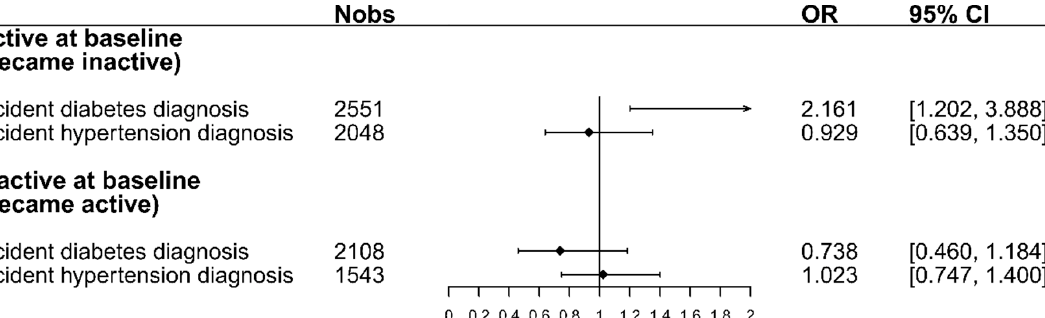
Figure 2. Overview of the cases with incident diagnosis of diabetes or hypertension for the active and inactive strata by PA change. See Figures S1 and S2 in the supplement for a detailed overview of how the presented numbers were derived. Numbers of observations for the combination of both follow-up periods: Active-Diabetes = 2722; Active-Hypertension = 2174; Inactive-Diabetes = 2298; Inactive-Hypertension = 1679. Deviations from the numbers of Figures 2 and 3 are due to missing values in covariates for which the models of Figure 3 were adjusted. Abbreviations: PA = physical activity; S4 = baseline study (2000); F4 = first follow-up (2007); FF4 = second follow-up (2014).